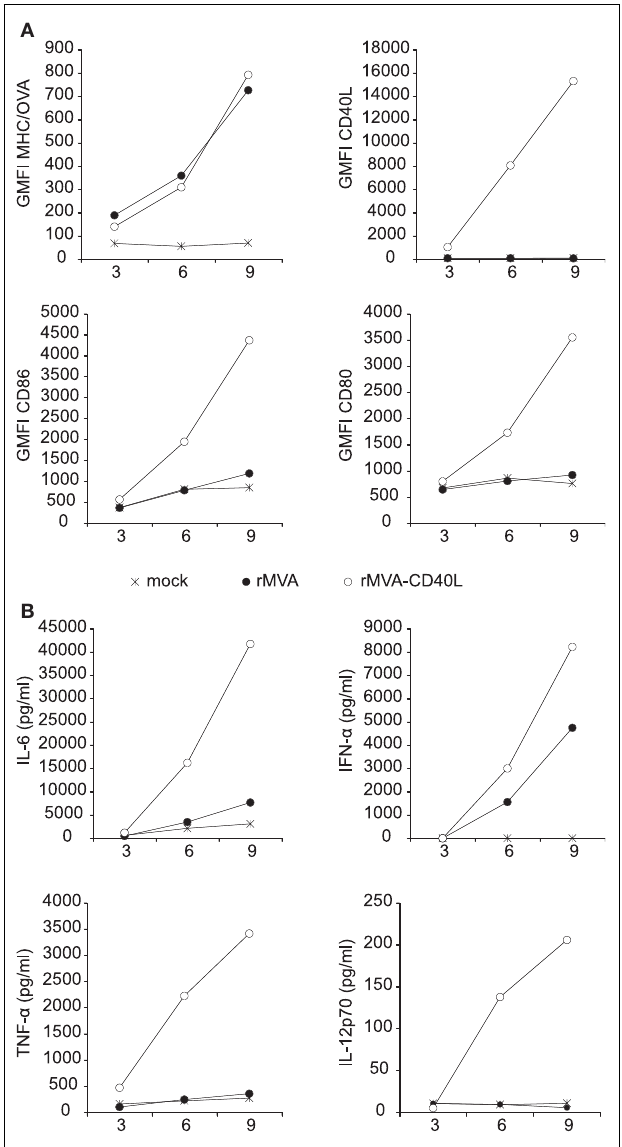
FIGURE 3 |Transduction of FLDCs in vitro with rMVA-CD40L leads to superior DC activation and cytokine secretion . In vitro generated FLDCs were transduced with rMVA or rMVA-CD40L (MOI2). (A) Three, six, and nine hours after transduction DCs were analyzed for OVA (H-2Kb/OVA 257–264 complexes) and CD40L expression and the activation markers CD86 and CD80. Note that OVA expression is not different between rMVA and rMVA-CD40L. (B) At the same time points as in (A) supernatants were analyzed for IL-6, IFN- α ,TNF- α , and IL-12p70 by a cytometric bead assay. Note that IL-12p70 andTNF- α were only detectable after transduction with rMVA-CD40L but not rMVA. Data are representative of at least two independent experiments. Shown is the mean of duplicate